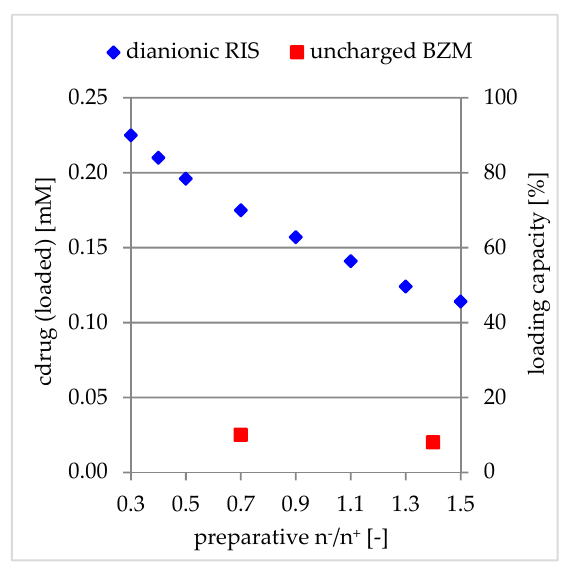
Figure 11. Loading capacity of PEC NP in dependence of net charge related to uncharged BZM (PLL/PLG/PDOPAC) (red) in comparison to dianionic risedronate (PLL/CS1.0) (blue).